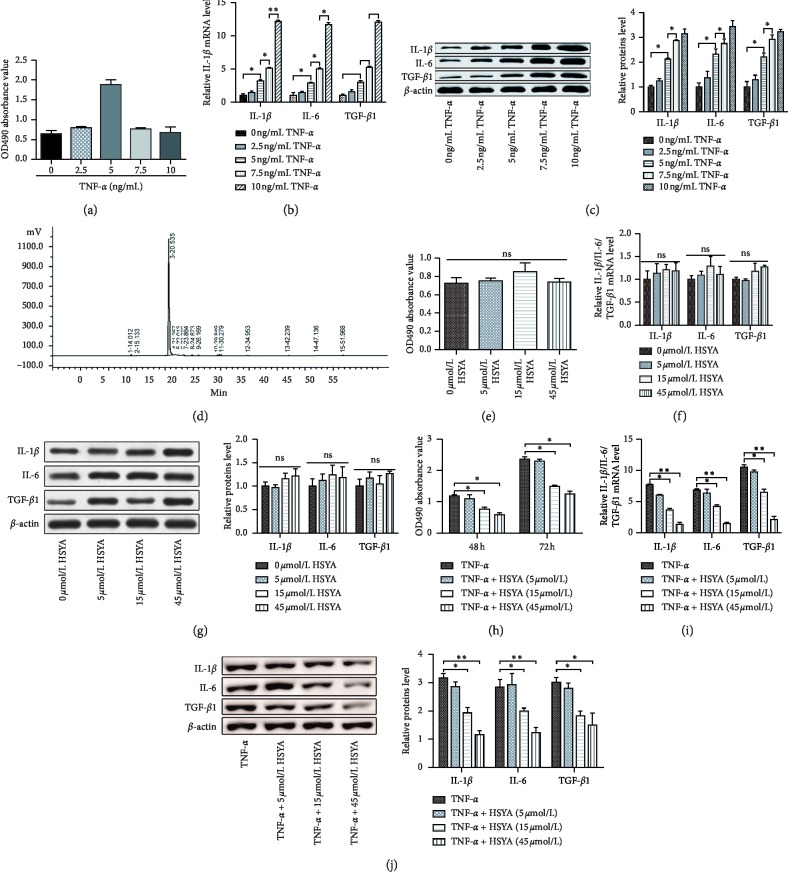
Effect of HSYA on TNF-α-induced proliferation and inflammatory response of MRC-5 cells. (a), (e), and (h), MTT assays were used to detect the effect of TNF-α or/and HSYA on the proliferation of MRC-5 cells; (b), (f), and (i), quantitative RT-PCR was used to detect the mRNA expression levels of IL-1β, IL-6, and TGF-β1; (c), (g), and (j), IL-1β, IL-6, and TGF-β1 protein expression levels were determined by western blot analysis; (d); high-pressure liquid chromatography analysis of HSYA; HSYA retention time was 20 min; HSYA, hydroxysafflor yellow A; ∗P < 0.05; ∗∗P < 0.01; ∗∗∗P < 0.001.